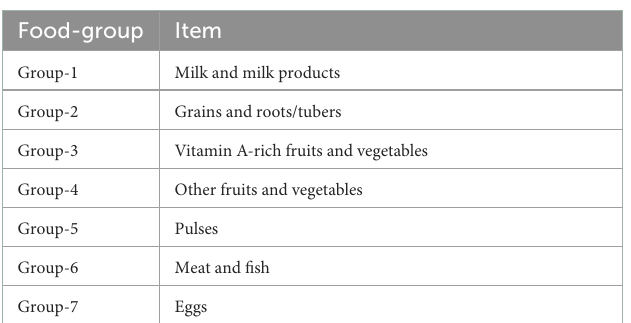
TABLE 1 Food-groups and